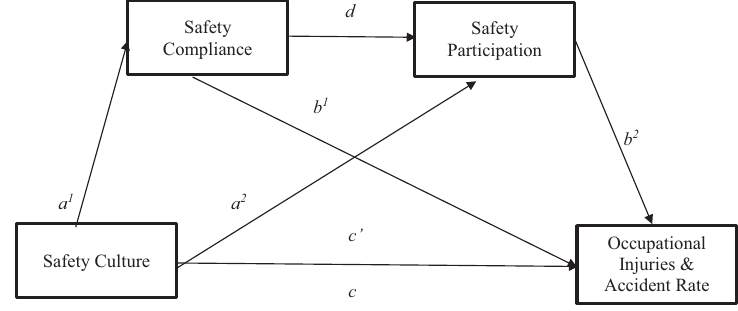
Figure 1. Research framework with sequential